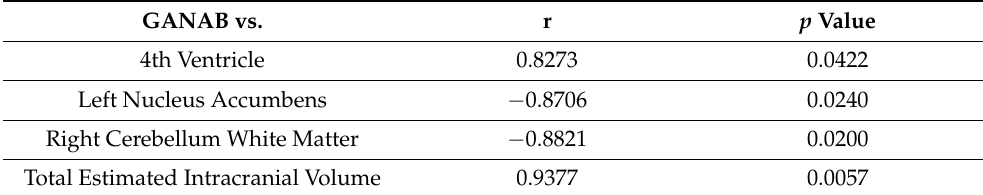
Table 3. Significant correlations between the mean quantitative expression of GANAB and some cortical/sub-cortical segmented brain regions from the considered IFN-treated MS group. Bonferroni correction for multiple comparisons was applied.